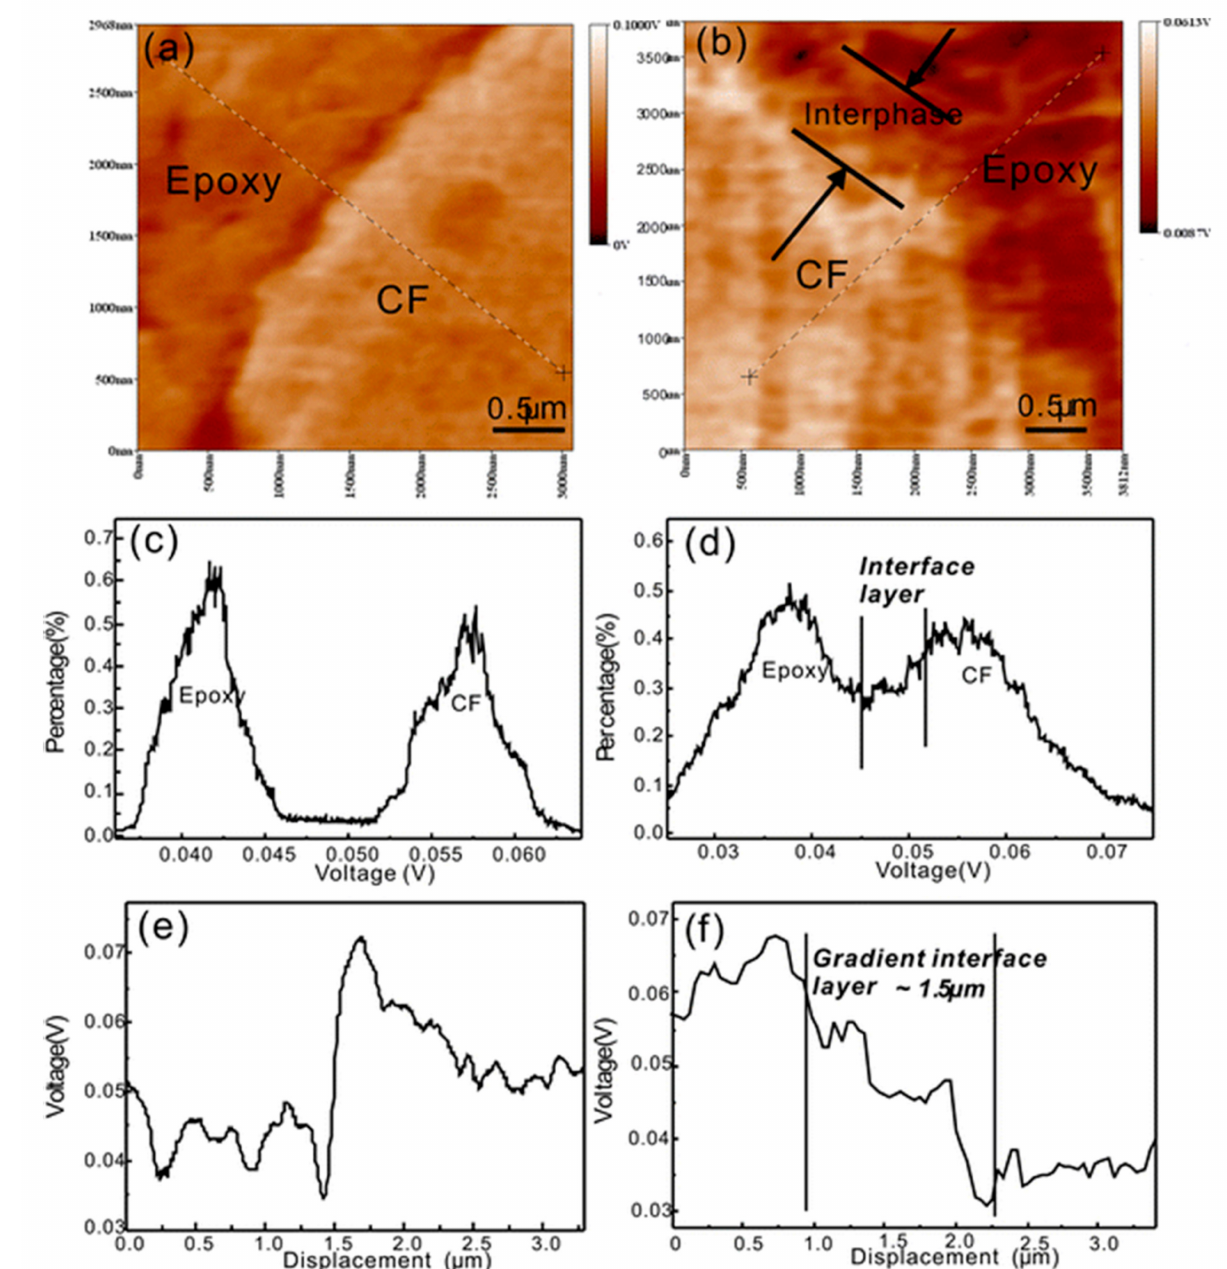
Figure 7. ( a , b ) Relative stiffness in the interphase region obtained by force modulation AFM, ( c , d ) probability histograms of relative stiffness and ( e , f ) stiffness change tendency with the appearance of a gradient interface layer between carbon fibres and epoxy resin for hierarchical carbon fibres modified with 1 wt% graphene nanosheets ( d , f ) (reprinted with permission from Chen et al., 2015